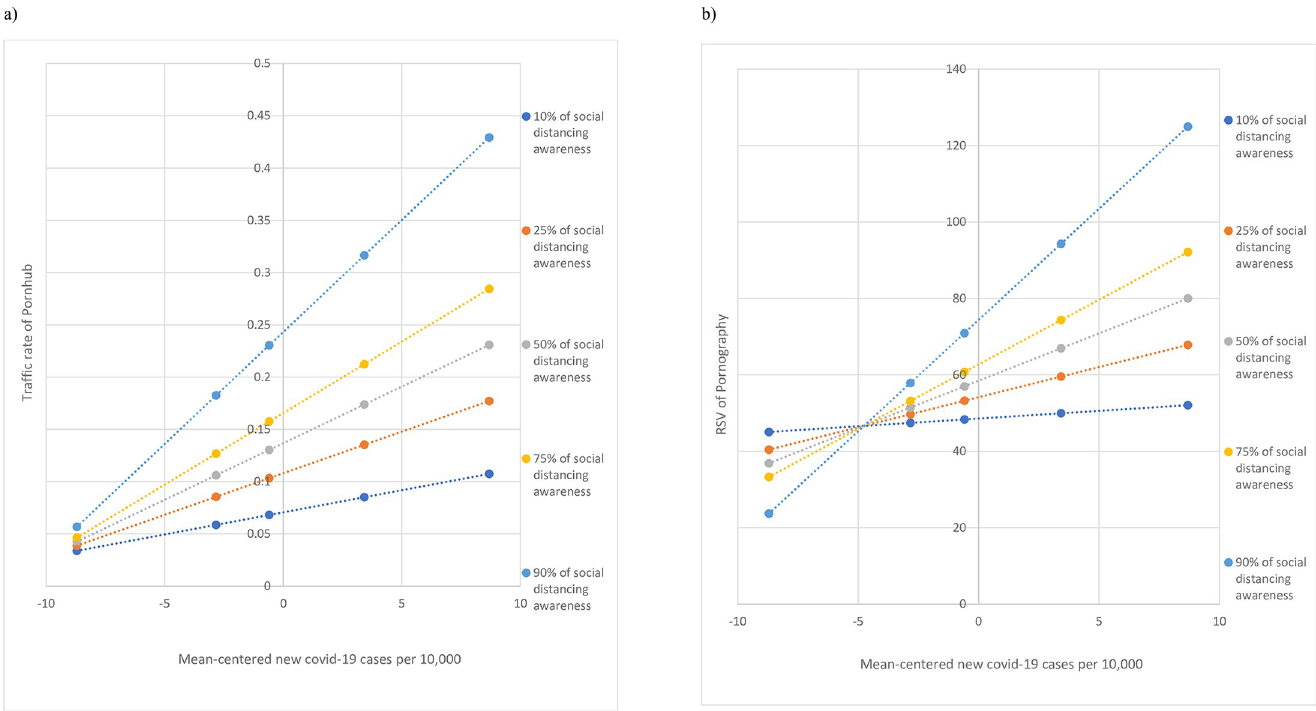
Fig 2. a: Moderation effect of the awareness of social distancing on the relationship between covid-19 new cases and traffic rate of Pornhub. b: Moderation effect of the awareness of social distancing on the relationship between covid-19 new cases and RSV of ‘pornography’.